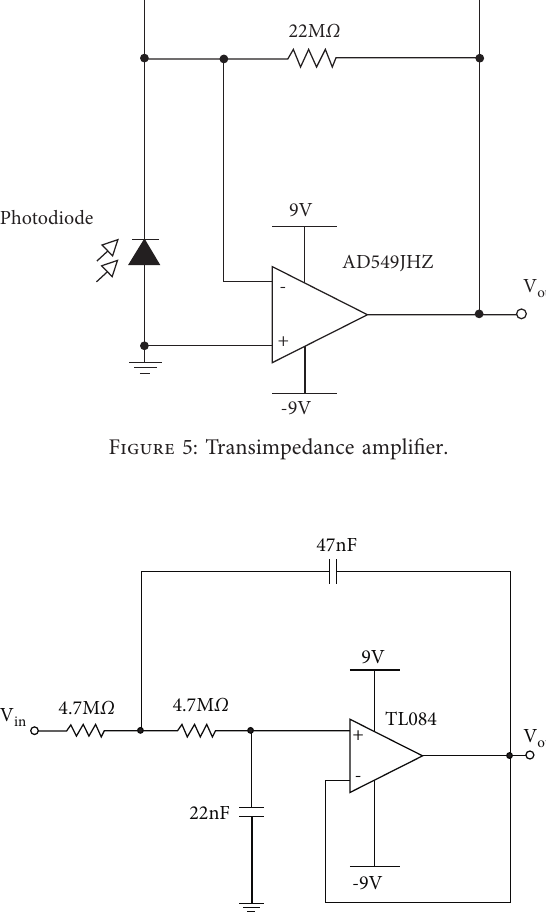
Figure 6: Low-pass filter Butterworth.